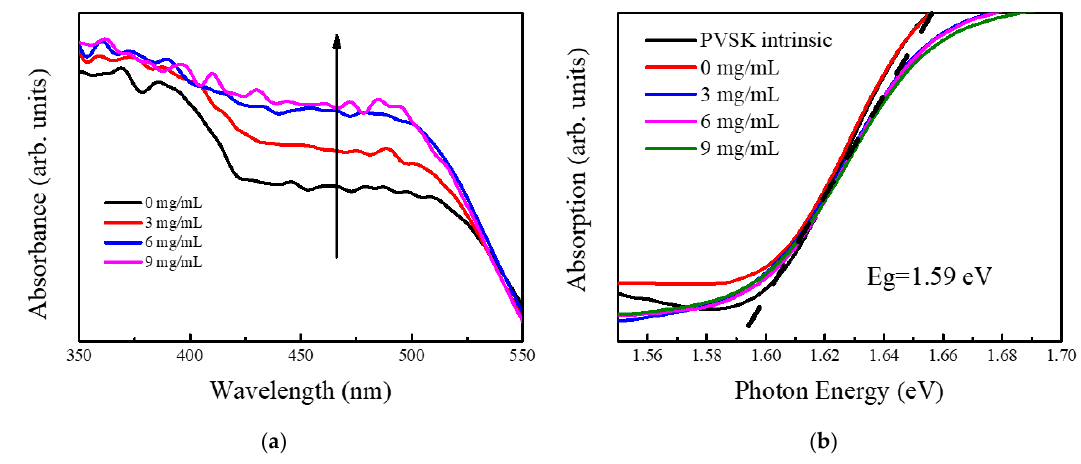
Figure 2. ( a ) Absorption spectra of films of pristine and oxidized spiro-OMeTAD layers and the